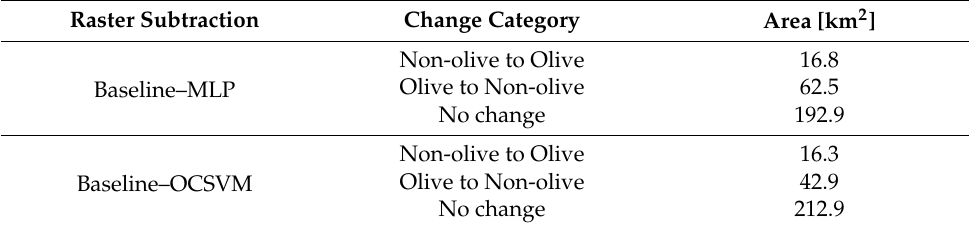
Table 3. The total area in km 2 based on each change category.